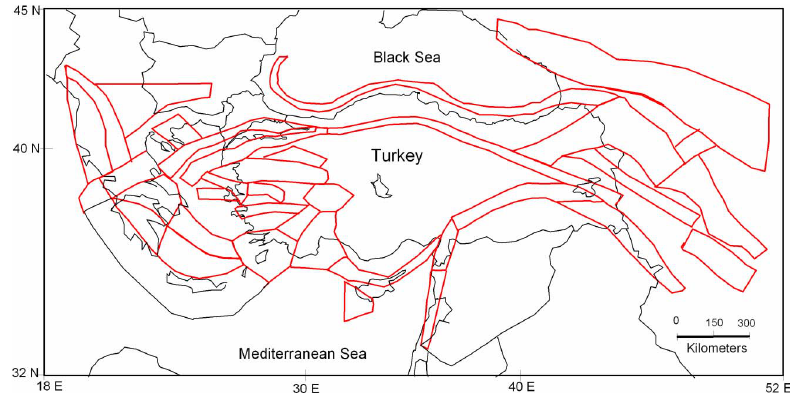
Figure 1. Seismogenetic zones of Turkey (redrawn from Erdik et al [5]) Fig. 1. Seismogenetic zones of Turkey (redrawn from Erdik et al.,